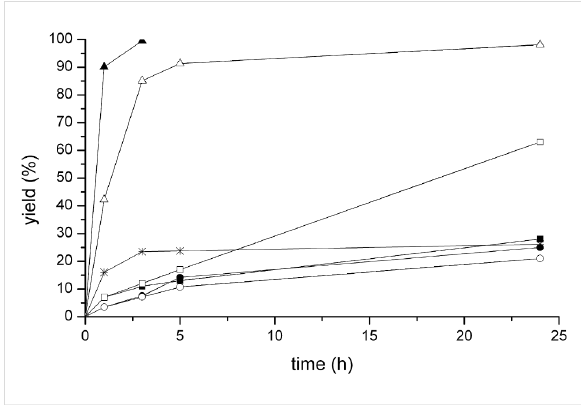
Figure 2: Yield in 3{ 1 , 1 } versus time diagram for the reaction of pentamethylbenzene and ethyl propiolate catalysed by complexes II – VII and KAuBr 4 at room temperature in HBF 4 and with added AgBF 4 : complex II (black squares); complex III (circles); complex IV (squares); complex V (black circles); complex VI (black triangles); complex VII (triangles); KAuBr 4 (asterisks). Reaction conditions: 1 equiv arene, 1 equiv alkyne, 1 equiv tetrafluoroboric acid, 0.1 mol % Au, 0.1–0.4 mol % AgBF 4 , 1,2-dichloroethane, 25